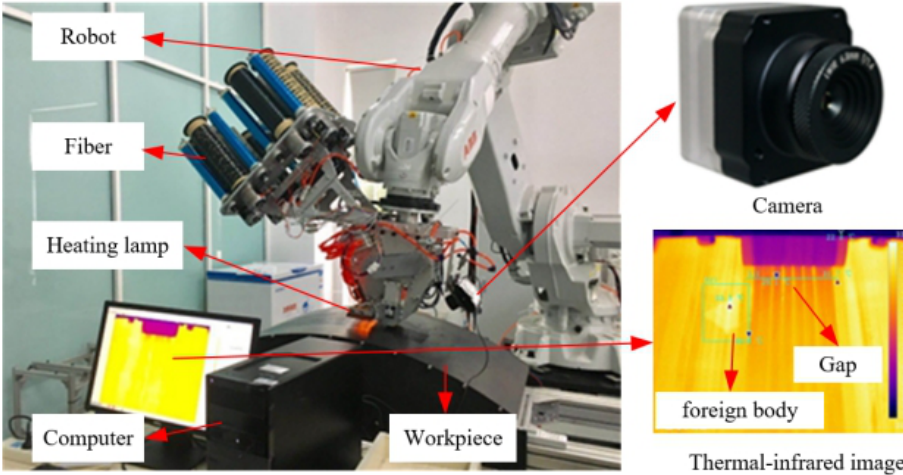
Figure 2. The active thermal-infrared visual measurement system.